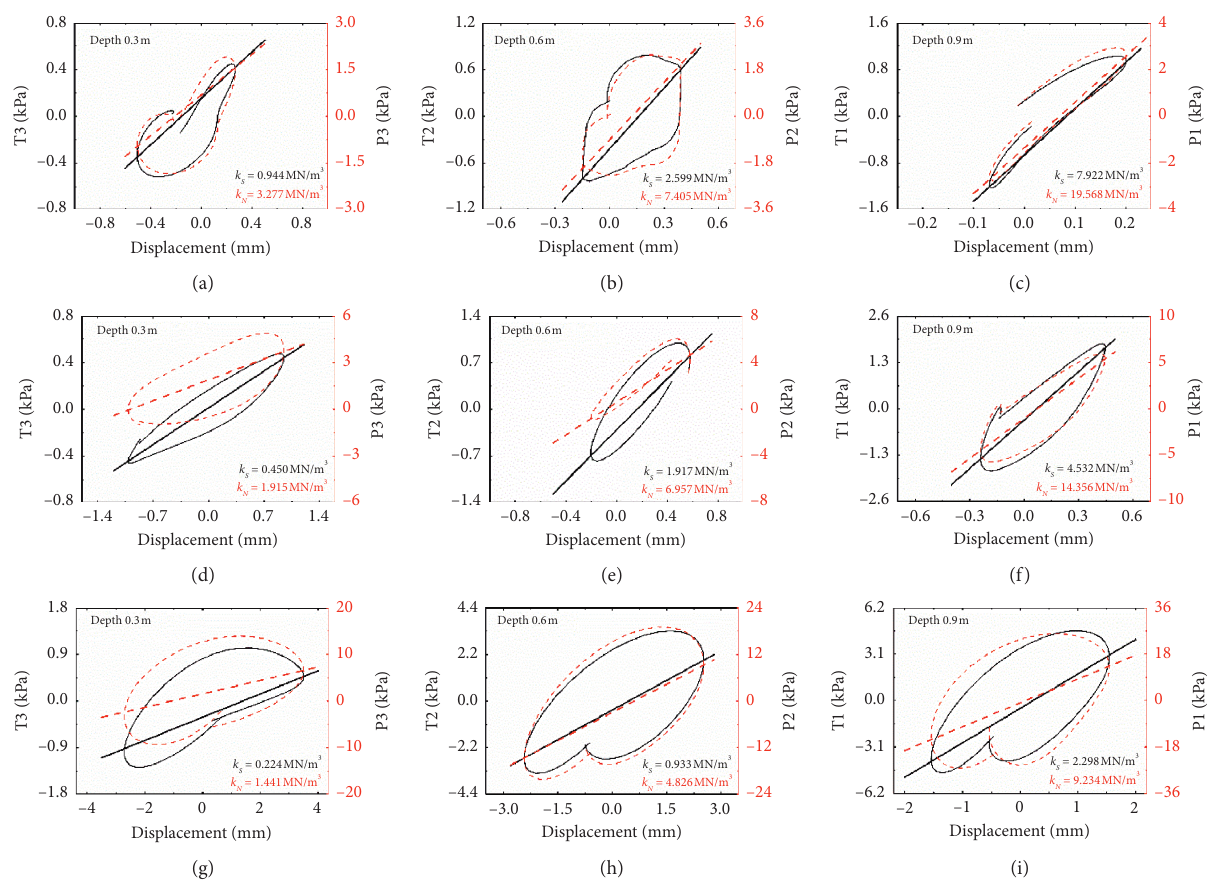
Figure 8: Presentative hysteretic loops of soil: (a) T3 and P3 under 0.1g excitation. (b) T2 and P2 under 0.1g excitation. (c) T1 and P1 under 0.1g excitation. (d) T3 and P3 under 0.2g excitation. (e) T2 and P2 under 0.2g excitation. (f) T1 and P1 under 0.2 g excitation. (g) T3 and P3 under 0.4 g excitation. (h) T2 and P2 under 0.4g excitation. (i) T1 and P1 under 0.4g excitation. Table 1: The horizontal equivalent subgrade reaction coefficients Table 2: Empirical values of the subgrade reaction and ratios of soil. Peak